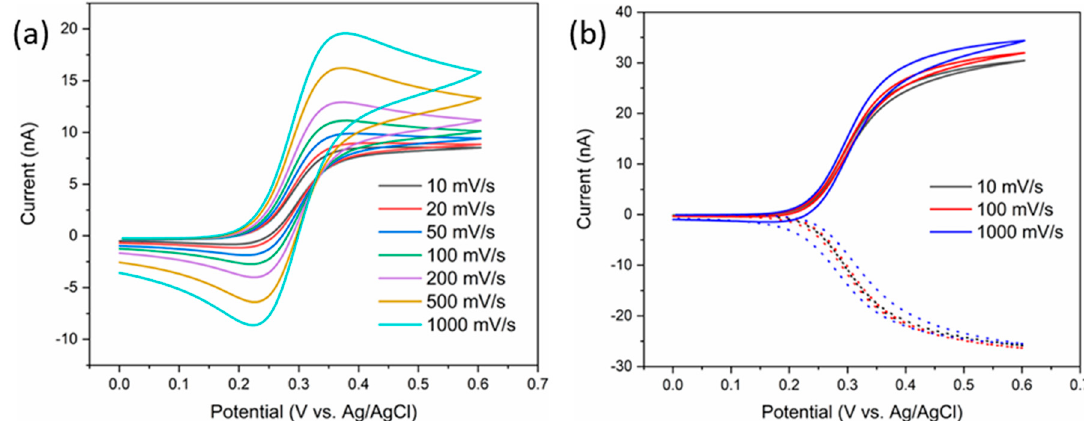
Figure 3. CVs of 1 mM FCA in 10 mM PBS, pH 7.4, at various scans rates with the collector ( a ) unbiased and ( b ) biased at 0 V vs. Ag/AgCl. The dotted curve in (b) represents the collector response to the CV at the generator electrode.